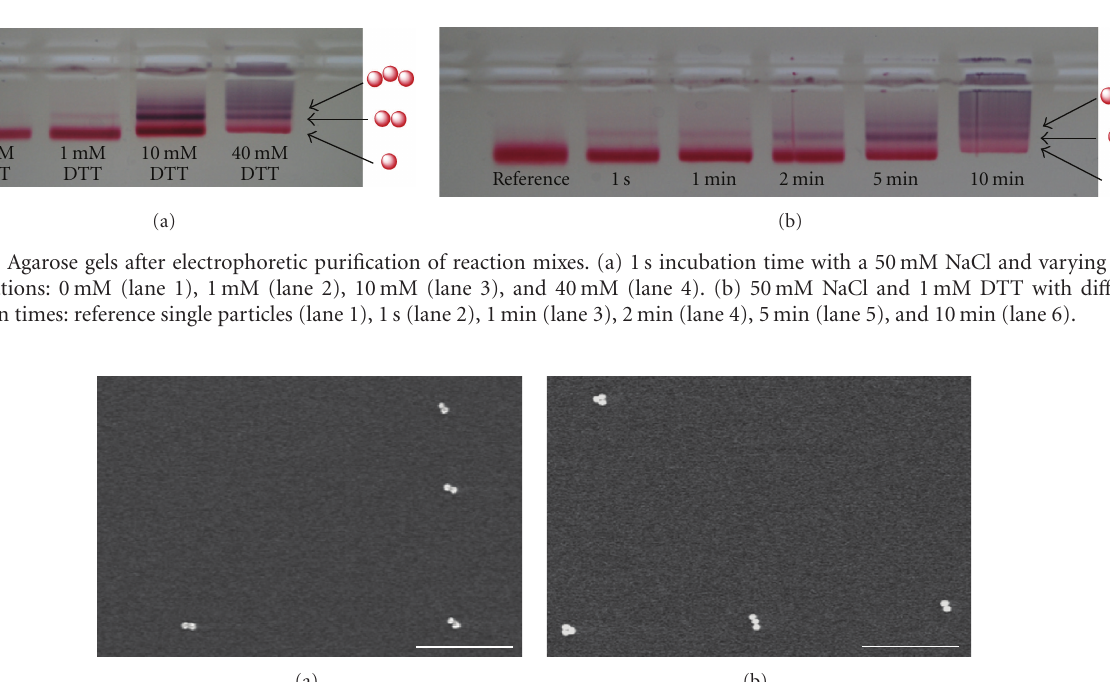
corresponds to the longitudinally coupled dipole mode [22,